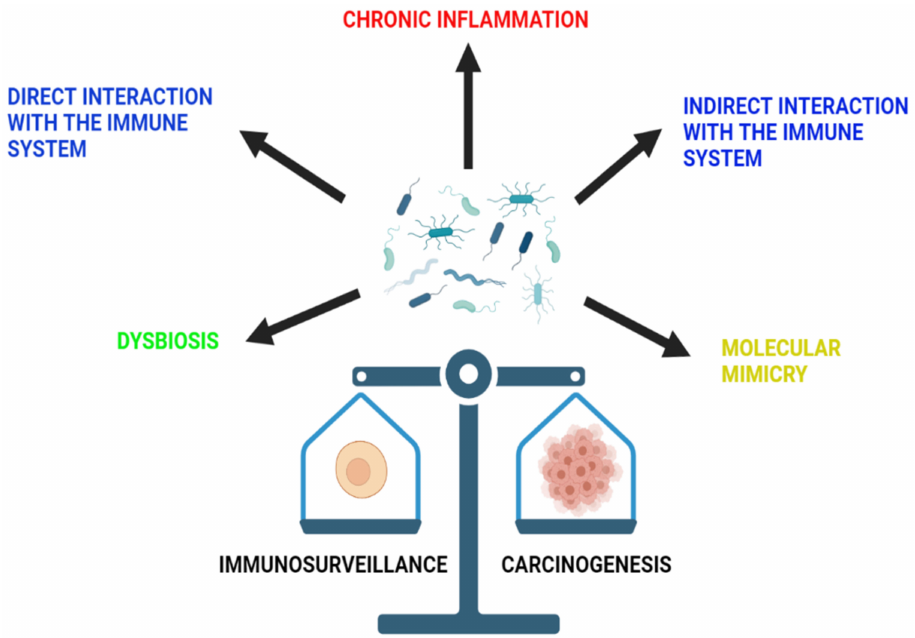
Figure 2. The role of microbiota in immunosurveillance and carcinogenesis. The microbiota of the gut is able to influence immunosurveillance and carcinogenesis through a variety of mechanisms. These include chronic inflammation, dysbiosis and direct and indirect interaction with the immune system, as well as molecular